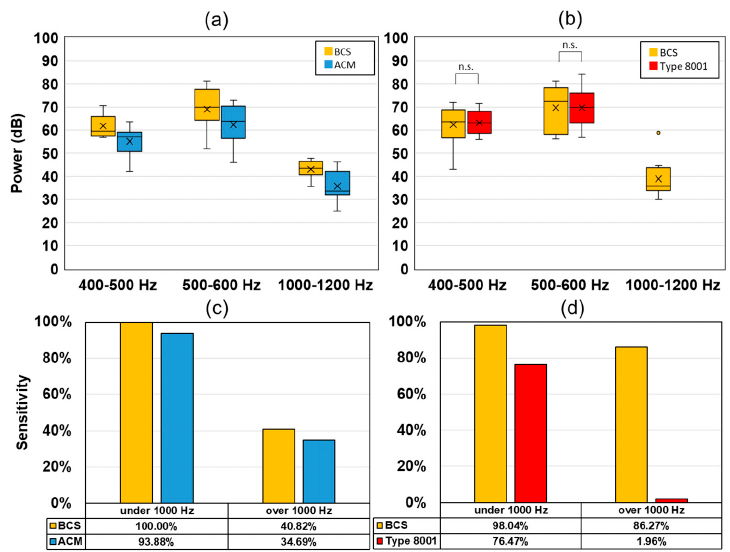
Figure 11. Experimental results of the wheezing sound from the oral transmission experiment. Wheezing detection power values for ( a ) BCS and ACM, ( b ) BCS and type 8001. Wheeze detection sensitivity (1000 Hz under/over), ( c ) BCS and ACM, and ( d ) BCS and type 8001.